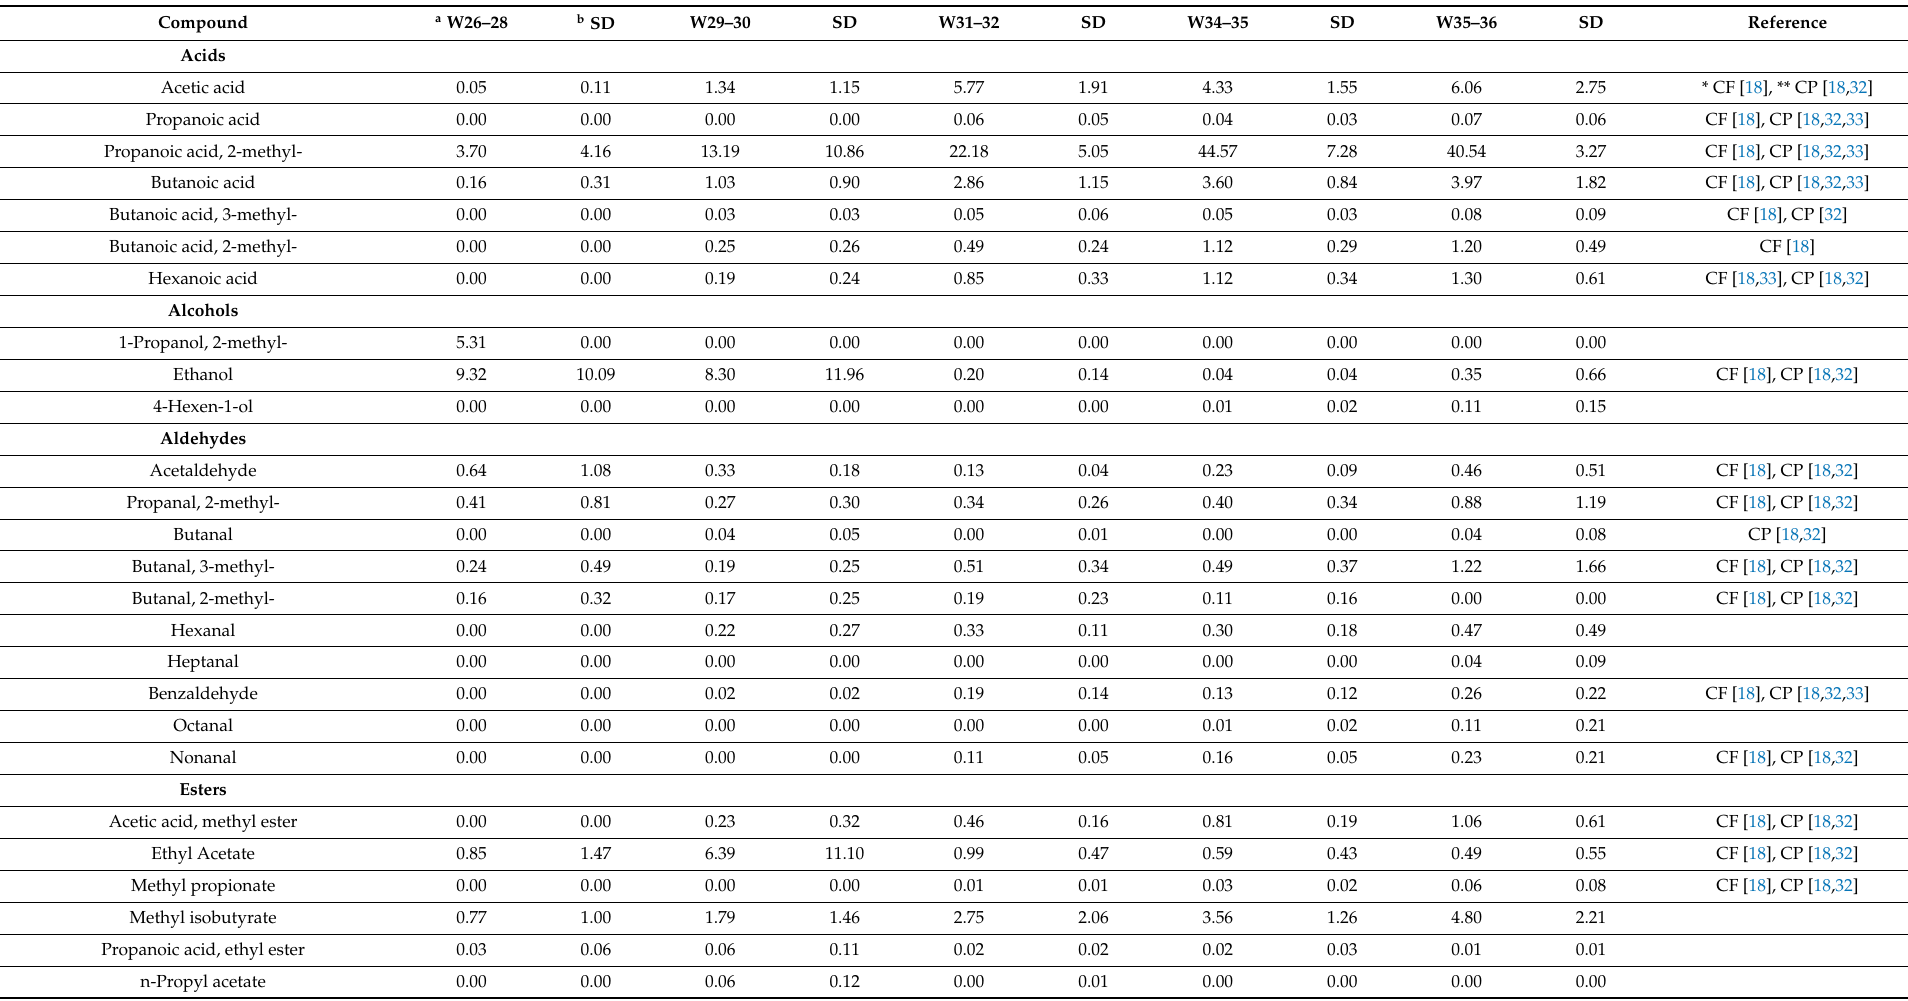
Table 2. Mean values